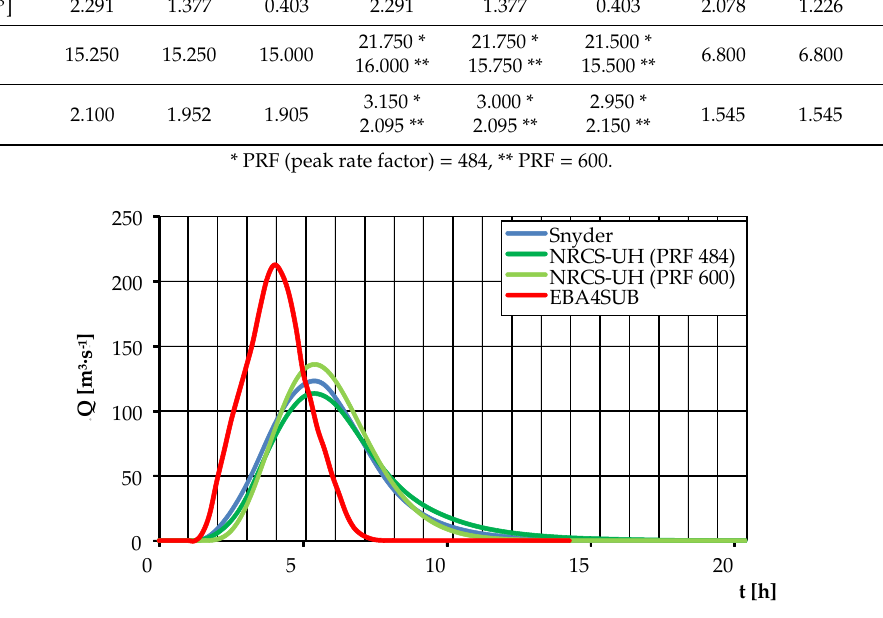
Figure 5. Design hydrograph for T = 500 years return period.